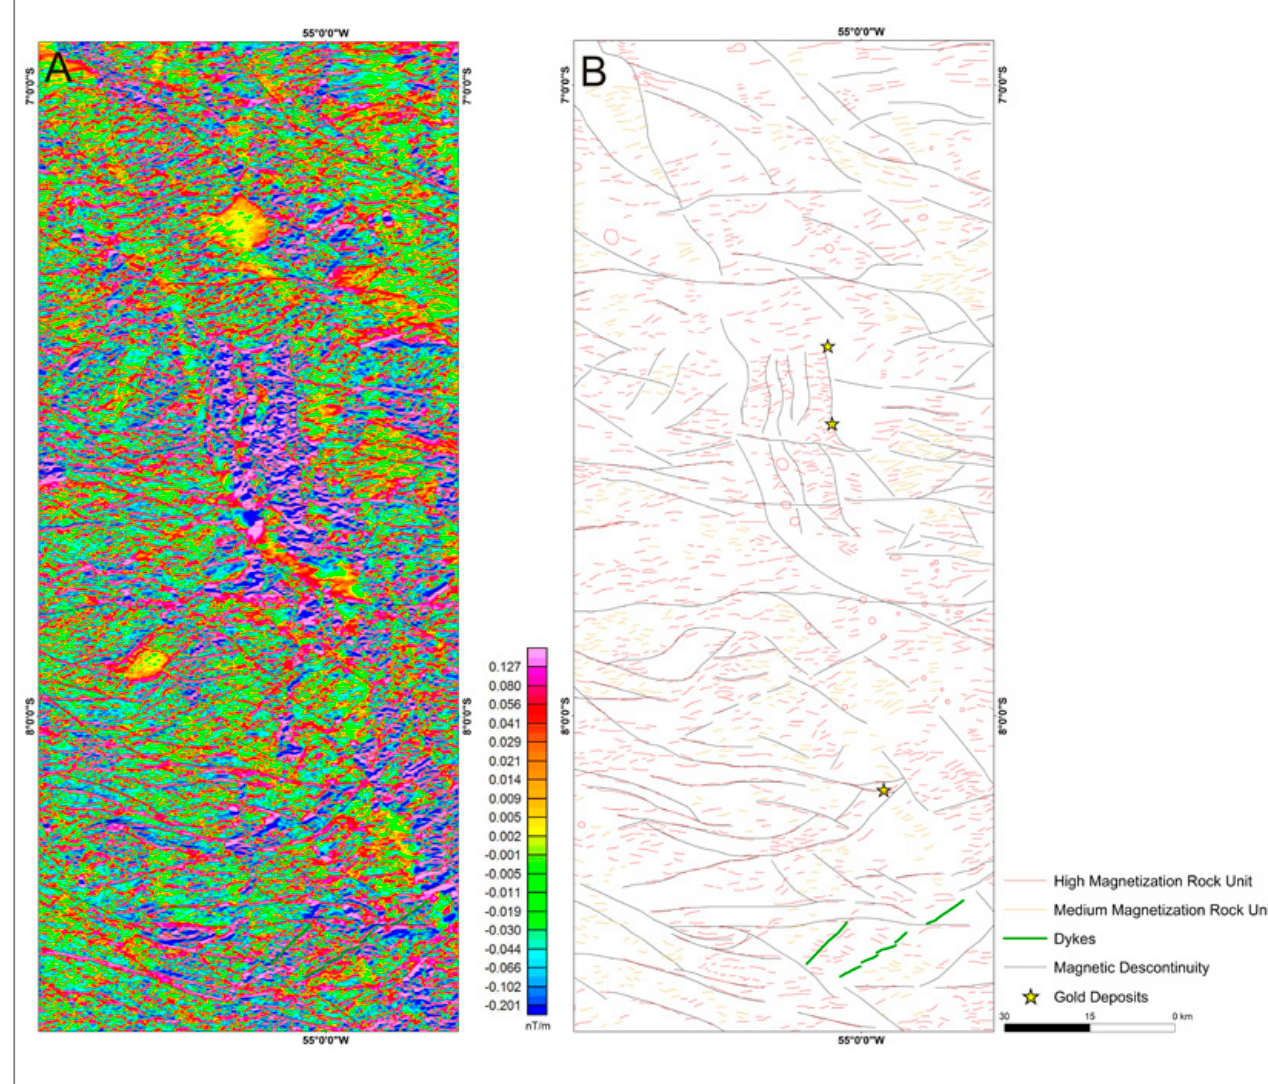
Figure 3 - A) Vertical derivative of the magnetic anomaly. B) Structural